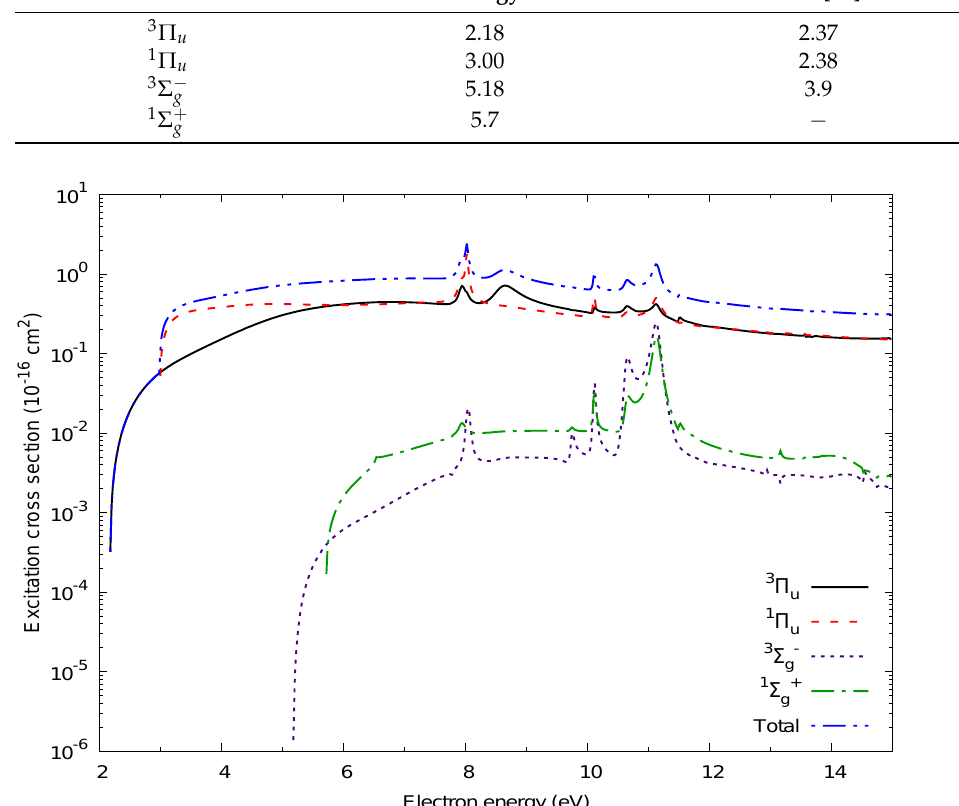
Figure 7. Cross sections for excitation to the 3 Π u , 1 Π u , 3 Σ − g , and 1 Σ + g states from the ground